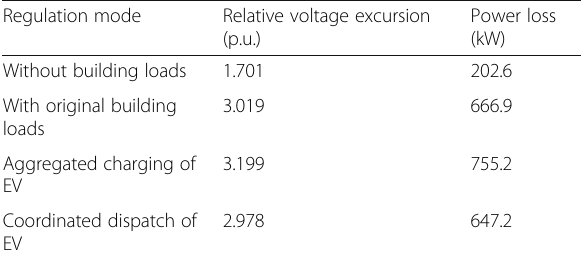
Table 1 Indices under different EV regulation modes Regulation mode Relative voltage excursion